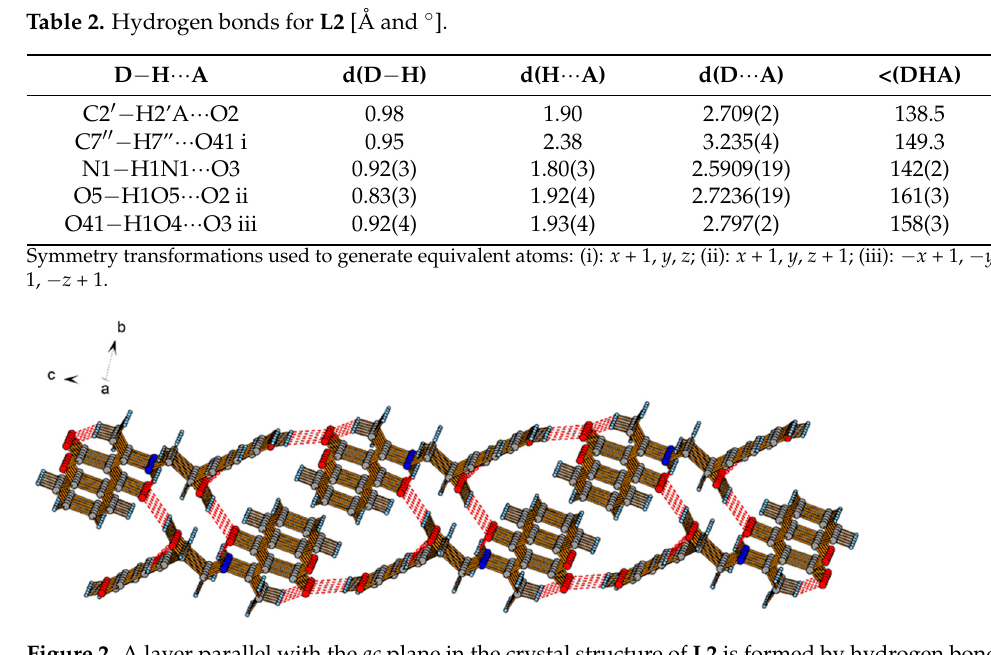
Figure 2. A layer parallel with the ac plane in the crystal structure of L2 is formed by hydrogen bonds (red dashed lines) viewed along the a -axis.